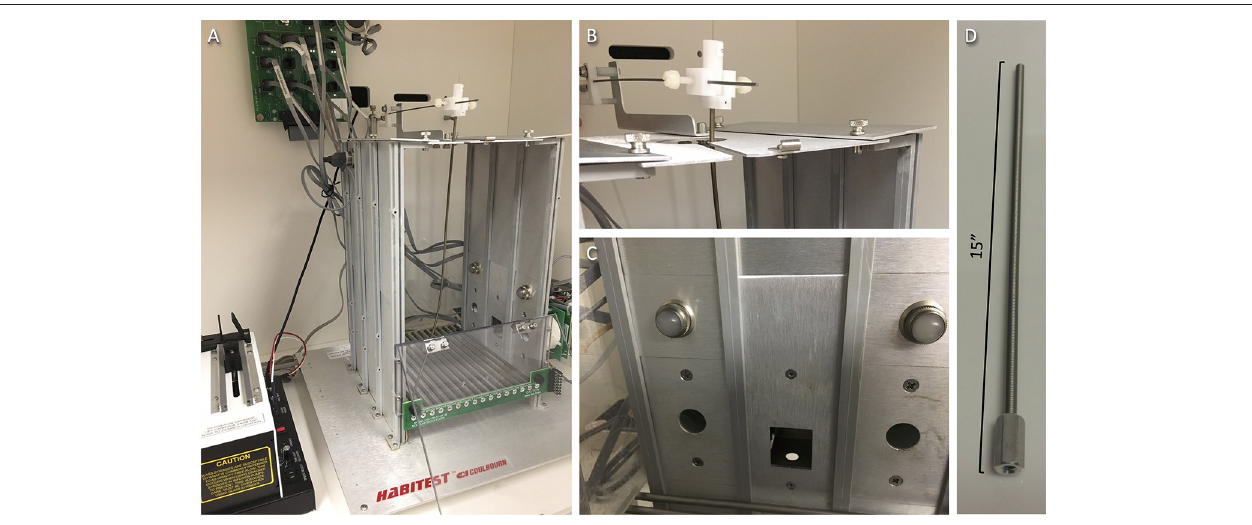
FIGURE 2 | Operant box set-up. (A) An example operant box arrangement inside a light-attenuated chamber. Plastic Tygon tubing (not shown) should run down a spring tether (to protect from chewing) and hang ∼ 4mm outside of the bottom where it can be attached to the mouse guide cannula, then the tether is screwed directly onto the guide cannula threading. At the top, the Tygon tubing should attach to a counterbalanced arm mounted above the chamber using a free-turning swivel (to avoid twisting the line/tether), then connect via a blunt-tipped needle to a drug or vehicle syringe (not shown) mounted in the syringe pump (shown left). A house light is located inside the upper left side of the chamber, out of view. (B) Closer view of a swivel and counterbalanced arm. (C) Closer view of manipulanda (nose poke ports), active and inactive, positioned at the left and right sides of one chamber wall, with visual discriminative cues (cue lights) arranged above each port. (D) Closer view of tether with connector matching the catheter guide cannula threading. Tether length may need to be shortened and weight position changed on the counterbalanced arm so that the tether has an ideal amount of slack; it should not pull down the catheter or impede the mouse’s ability to move or access all areas of the chamber